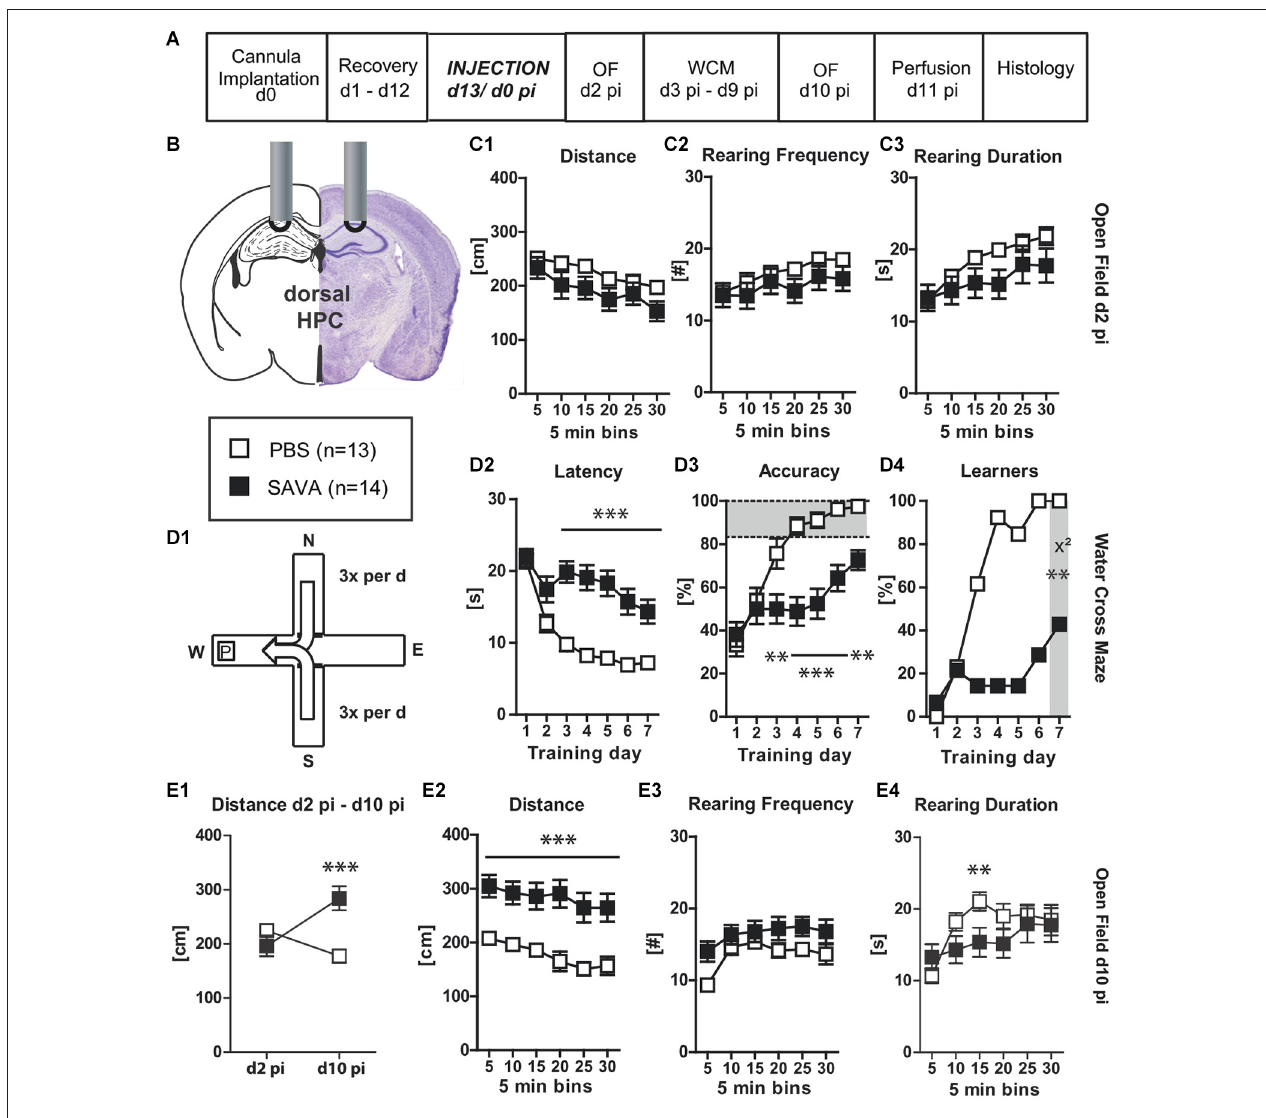
a-p − 1.8; v 1.0 mm from Bregma; injection of 0.5 µ l PBS or SAVA per cannula; groups and sample size; (C1–3) OF behavior d2 pi; (D1) basic schema of WCM; (D2–4) learning parameters in the WCM; (E1) OF Distance d2 pi vs. d10 pi; (E2–4) OF behavior d10 pi All data presented as mean ± SEM; ∗ p < 0.05, ∗∗ p < 0.01, ∗∗∗ p < 0.001 (Student’s t -test, chi 2 test or ANOVA followed by Tukey HSD post hoc test; abbreviations as in Figure 1